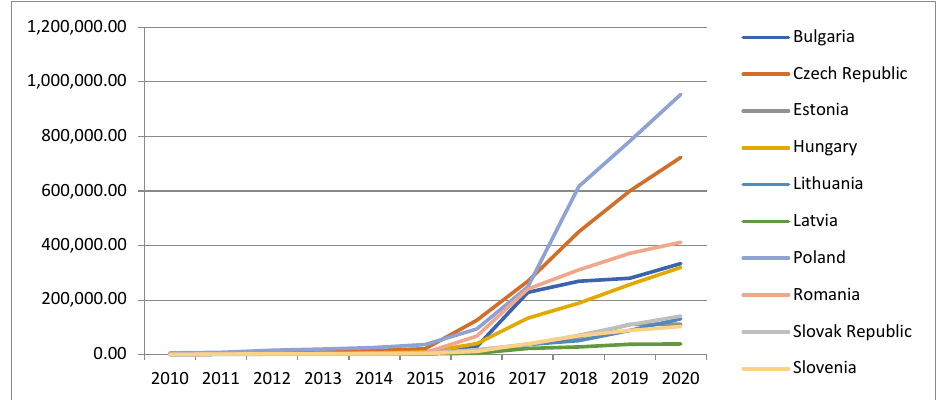
Figure 3. Secure internet servers—number of certificates.